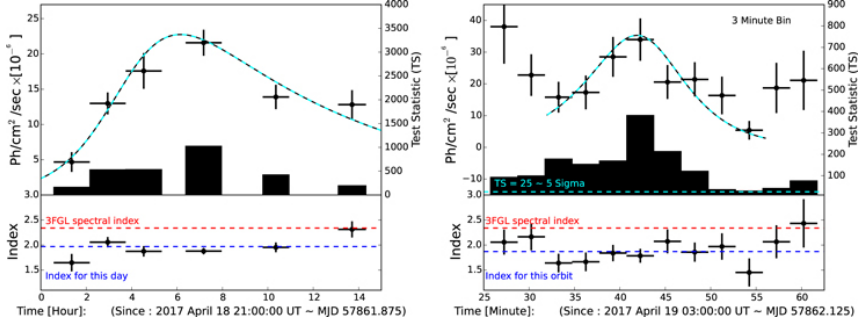
Figure 1. Fermi -LAT GeV γ -ray light curve of Cherenkov Telescope Array (CTA) 102 on 19 April 2017. Left : Orbit-binned light curve; Right : 3-min binned light curve (from] [33]). Reproduced with permission from the American Astronomical Society